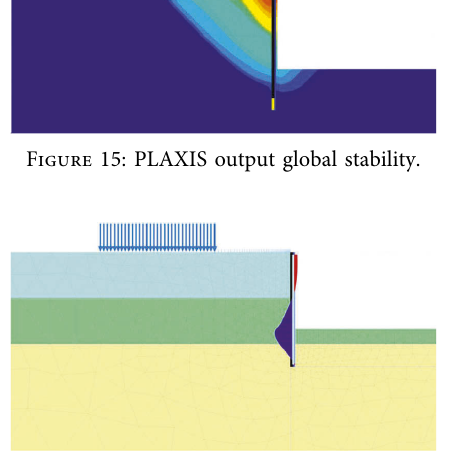
Figure 16: Bending moment diagram for PTP.